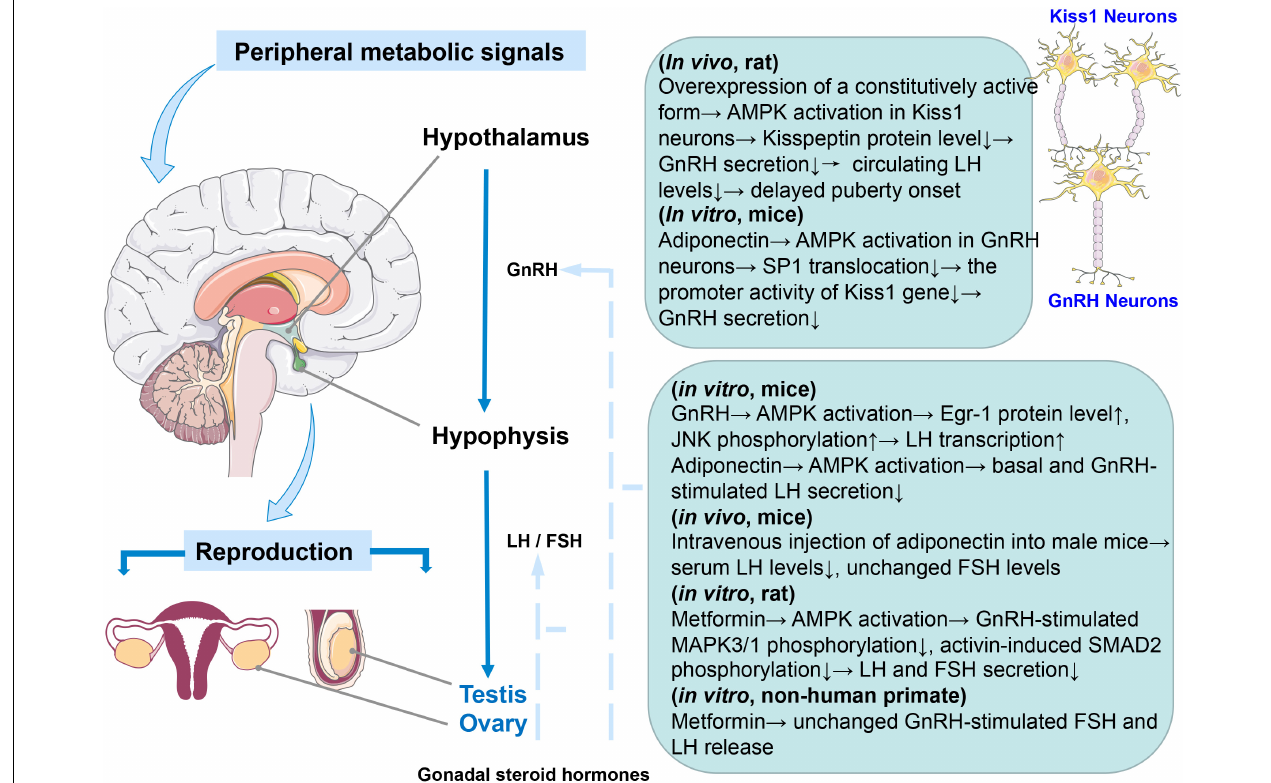
FIGURE 1 | Graphical summary of the effect of AMPK activation on the HPG axis. Species and in vivo or in vitro experiments are notified.